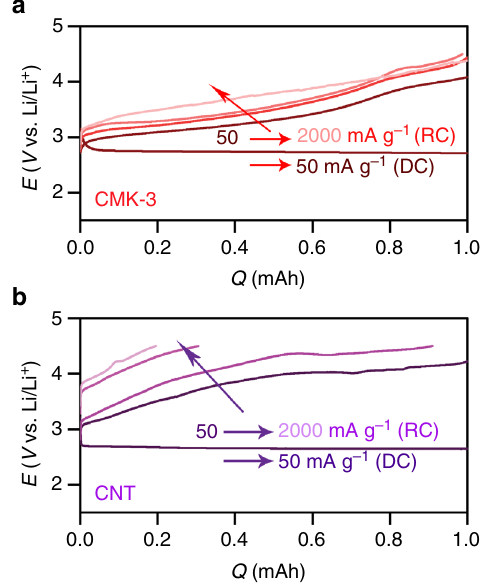
Fig. 8 Galvanostatic rate capability. a CMK-3 and b CNT electrodes after DC at 50 mA g – 1 carbon and capacity of 1.0 mAh. The RC was performed at a current rate of 50, 500, 1000, and 2000 mA g – 1 carbon (from dark to light color)